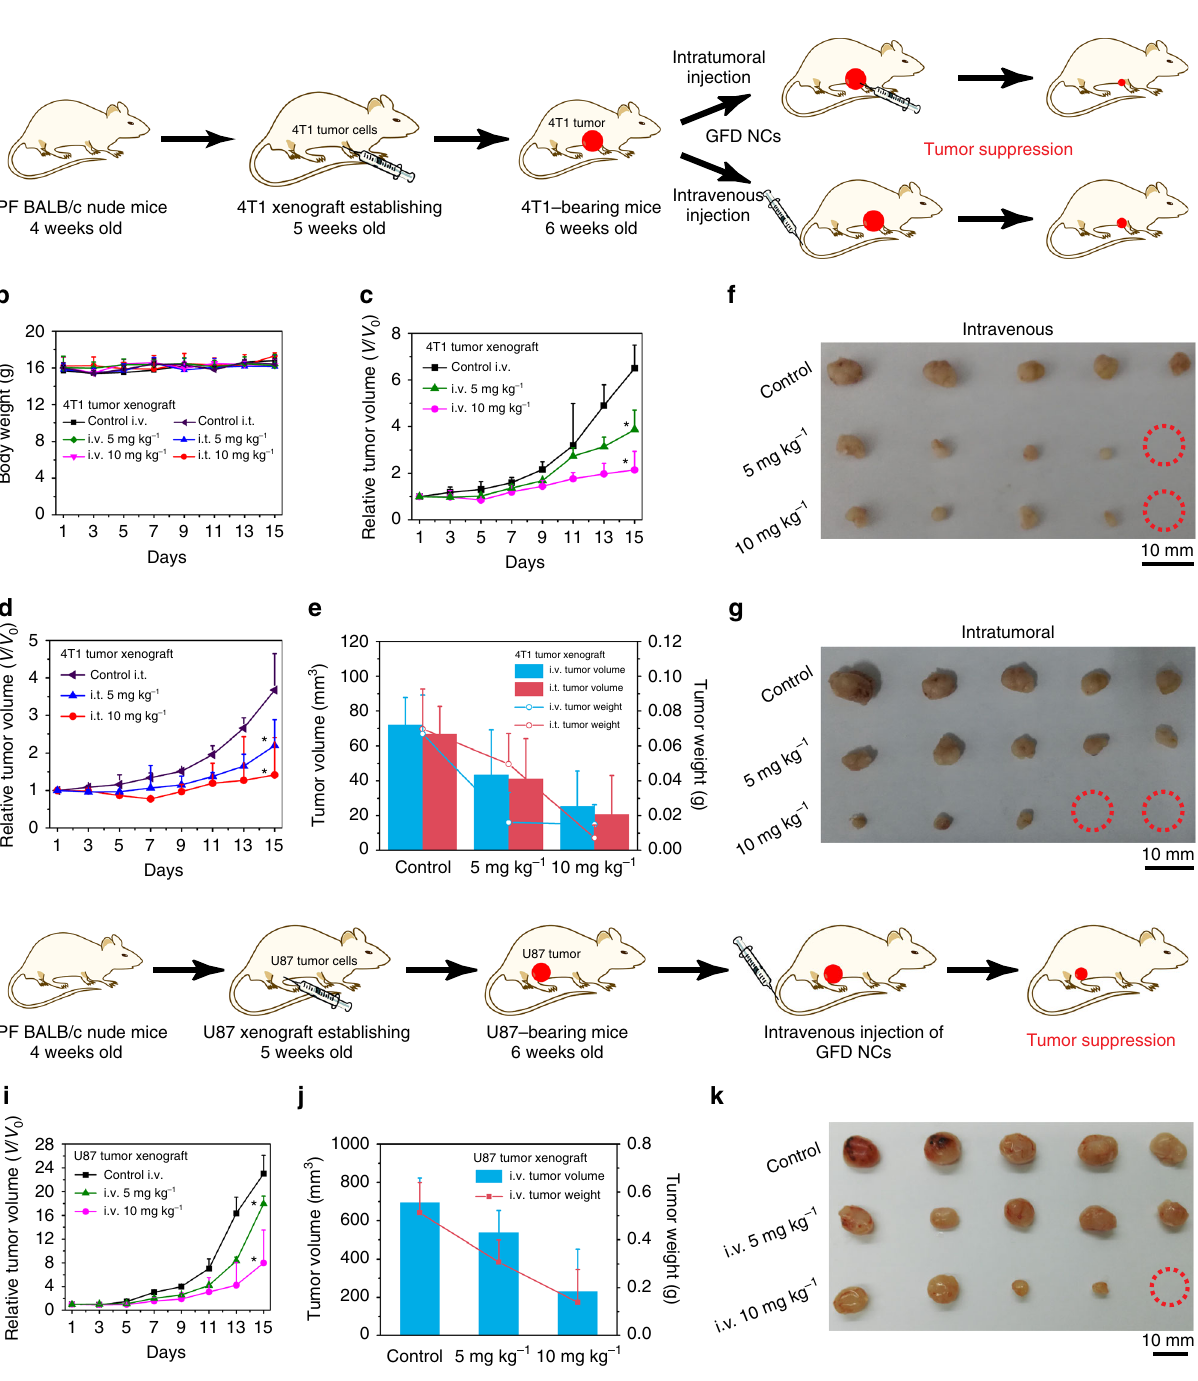
Fig. 7 In vivo catalytic-therapeutic performance of GFD NCs against 4T1 and U87 tumor xenografts. a Schematic illustration of 4T1 tumor xenograft establishment, saline and GFD NCs administration modalities, and therapeutic outcome. b The body weights of nude mice bearing 4T1 tumor xenografts after injections with saline (control group) and GFD NCs (5 and 10 mg kg − 1 , therapeutic group) intravenously and intratumorally, respectively. The relative tumor volumes of 4T1 bearing nude mice treated with saline (control group) and different doses of GFD NCs (therapeutic group) via ( c ) intravenous and ( d ) intratumoral modes ( n = 5). All the above data were collected and measured every 2 days. Statistical signi fi cance is assessed by Student ’ s one-sided t test compared to the control group. * p < 0.05, ** p < 0.01. e The tumor volumes and tumor weights of dissected tumors from each group after 15 days of therapies. Digital photographs of the dissected tumors from ( f ) intravenous and ( g ) intratumoral groups after 15 days of therapies. Red circles indicate the eliminated tumors. h Schematic illustration of U87 tumor xenograft establishment, saline and GFD NCs administration modalities, and therapeutic outcome. i The relative tumor volumes of U87 bearing nude mice intravenously injected with saline (control group) and GFD NCs (5 and 10 mg kg − 1 , therapeutic group) ( n = 5). Statistical signi fi cance is assessed by Student ’ s one-sided t test compared to the control group. * p < 0.05, ** p < 0.01. j The tumor volumes and tumor weights of dissected tumors from each group in 15 days of therapies. k Digital photographs of the dissected tumors from each group in 15 days of therapies. Red circles indicate the eliminated tumors. Mean values and error bars are de fi ned as mean and s.d., respectively. i.t. intratumorally; i.v.